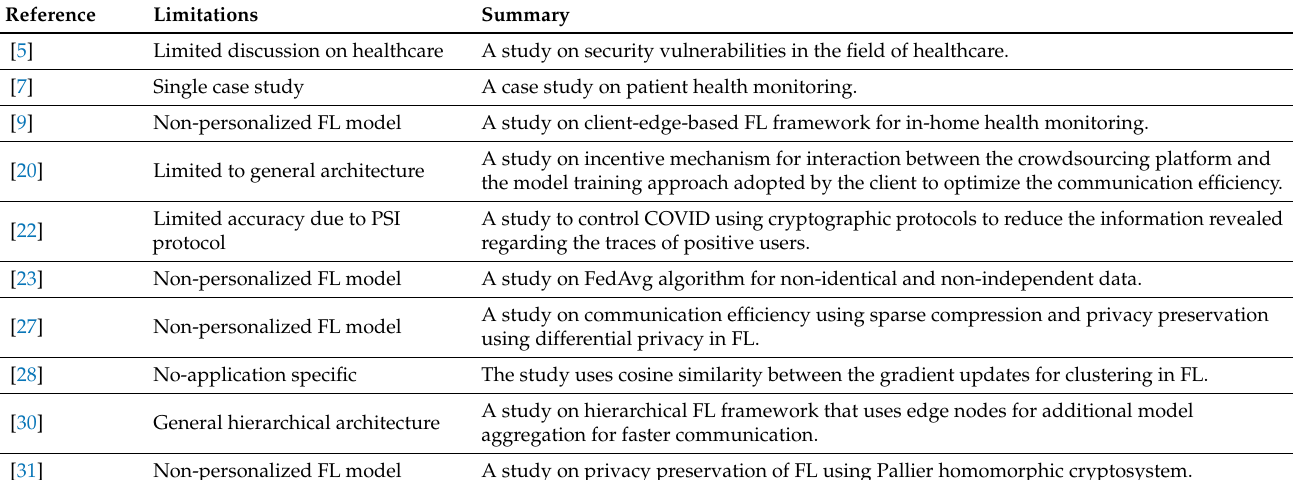
Table 1. Summary of existing schemes and their